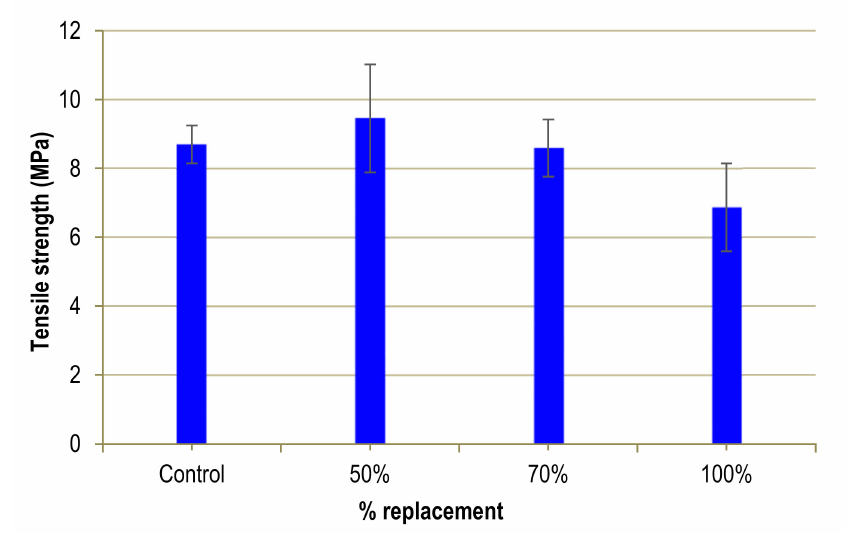
Figure 10. Tensile strength of